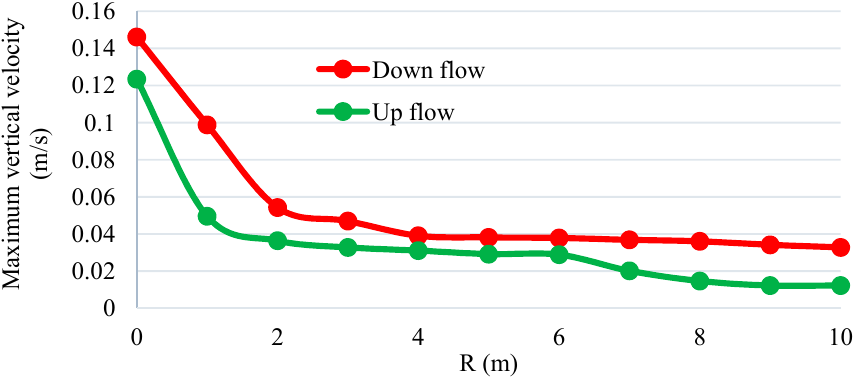
Figure 13. Variation tendencies of the maximum velocities of up- and down-flow.